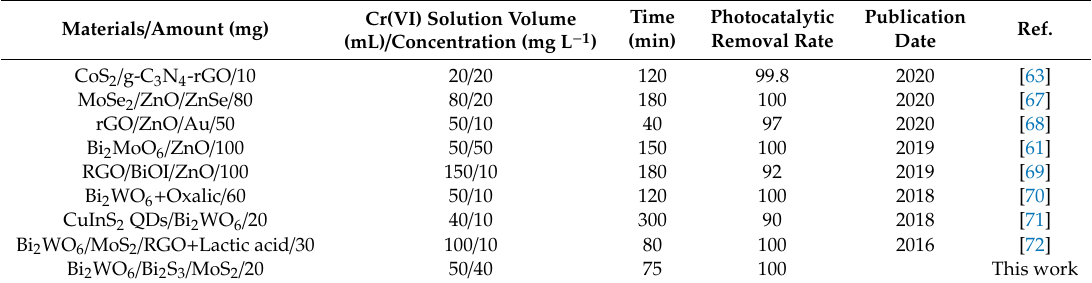
Table 2. Performance comparison with other materials used for vis-light catalytic reduction of Cr(VI). Materials / Amount (mg)